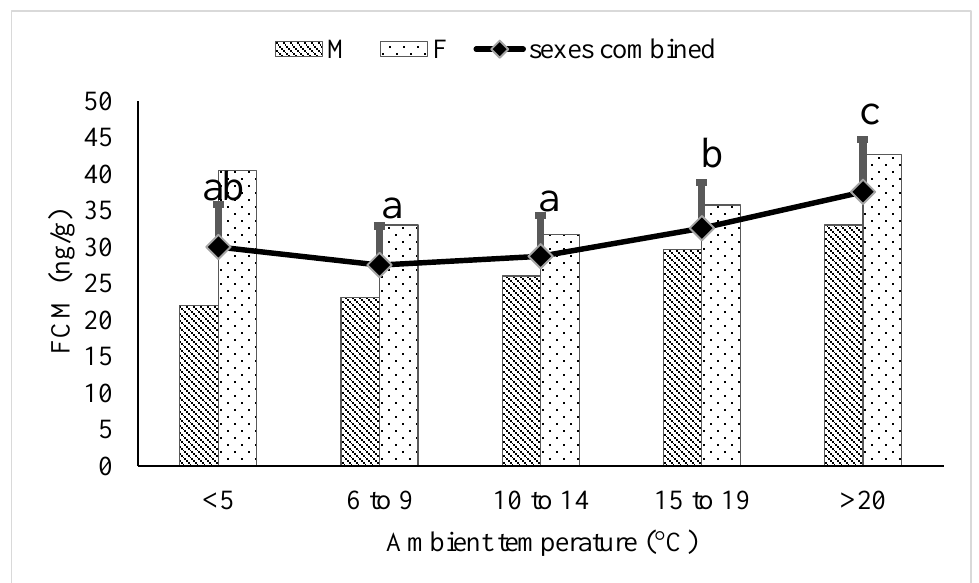
Figure 5. Back-transformed LSMeans ± SEM for fecal cortisol metabolite (FCM) concentrations (ng/g dry feces) within different ambient temperature categories for adult (6–17 years) polar bears during the non-breeding season (May to January) (N samples = 4119). Different subscripts represent differences between temperature categories ( p < 0.05). Columns represent sex-specific back-transformed LSMeans for each temperature